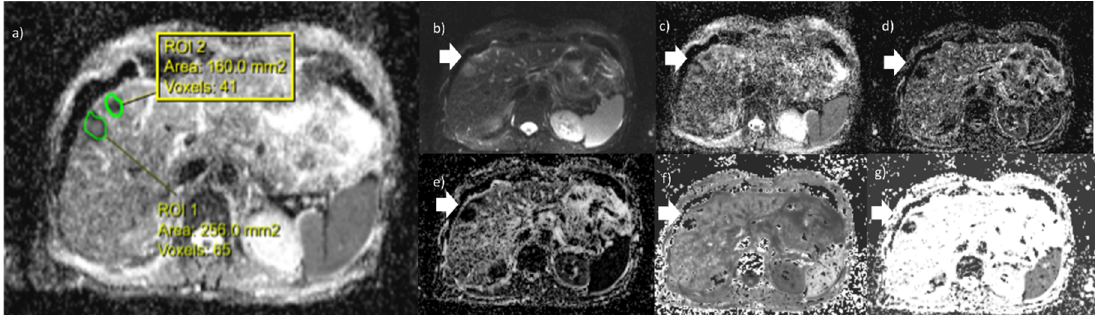
Figure 3. Representative case with two liver metastases and all DWI- and DKI-derived parameters maps: ADC map ( a ), S0 map ( b ), DT map ( c ), DP map ( d ), FP map ( e ), MK map ( f ), MD map ( g ).